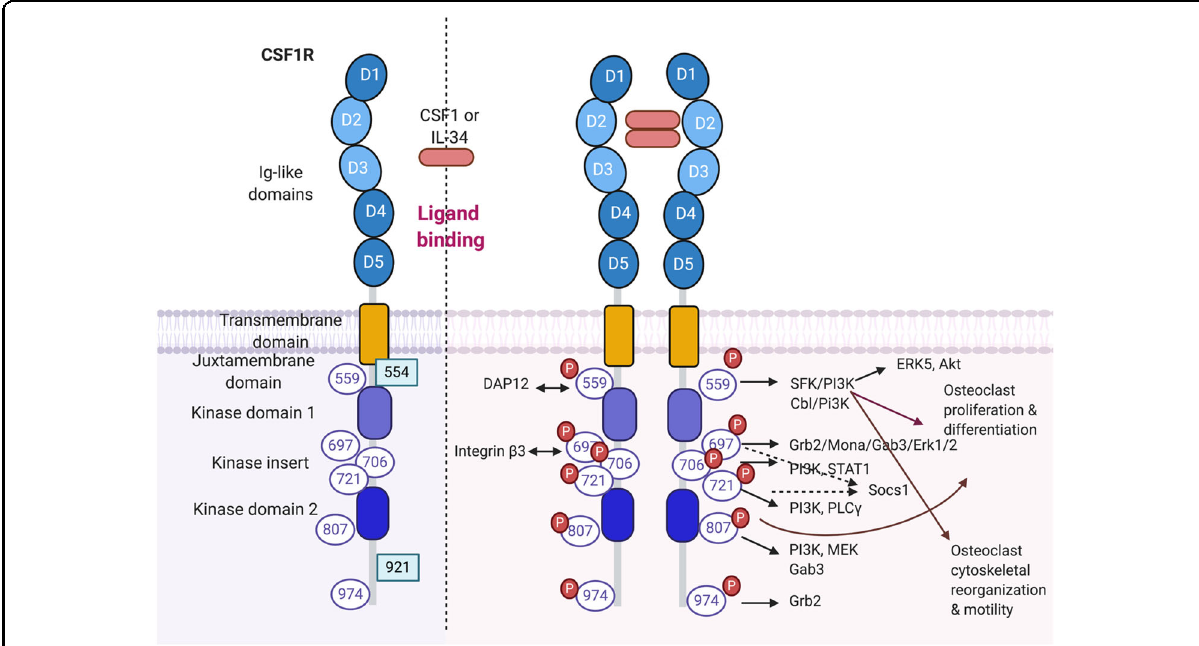
Fig. 2 Structure of CSF1R protein. The left panel shows the structure of CSF1R. The extracellular regions have fi ve Ig-like domains; D2 and D3 are ligand binding domains. The intracellular domains consist of the transmembrane domain, the juxtamembrane domain, two-kinase domains, a kinase insert, and cytoplasmic domains. CSF1R is a receptor tyrosine kinase and has 6 tyrosine residues that are phosphorylated upon ligand binding (purple circle). Green square: phosphorylated tyrosine in the v-FMS oncogenic receptor. Ligand engagement of CSF1R induces dimerization and phosphorylation of tyrosine residues. Phosphorylated tyrosines serve as docking sites for Src homology domain 2-containing signaling molecules to promote osteoclast differentiation, proliferation, cytoskeletal reorganization, and